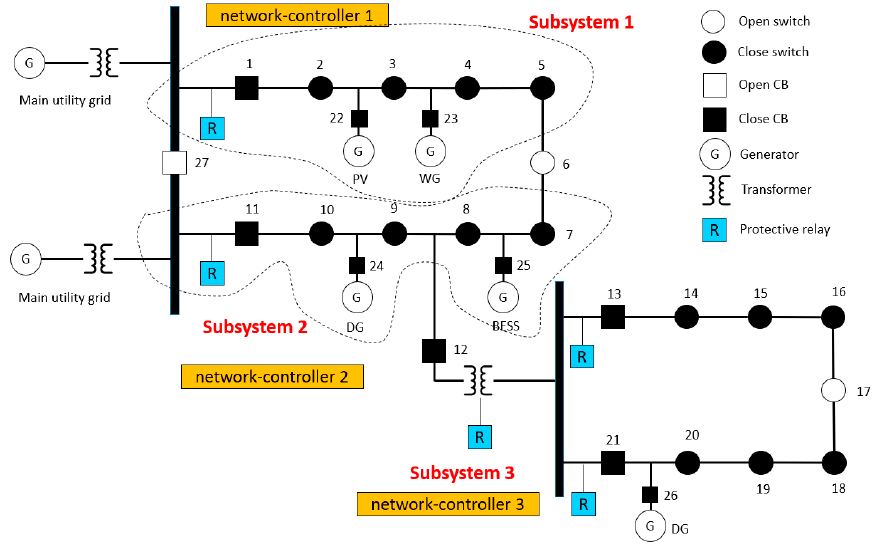
Figure 2. Single line diagram of the microgrid system.